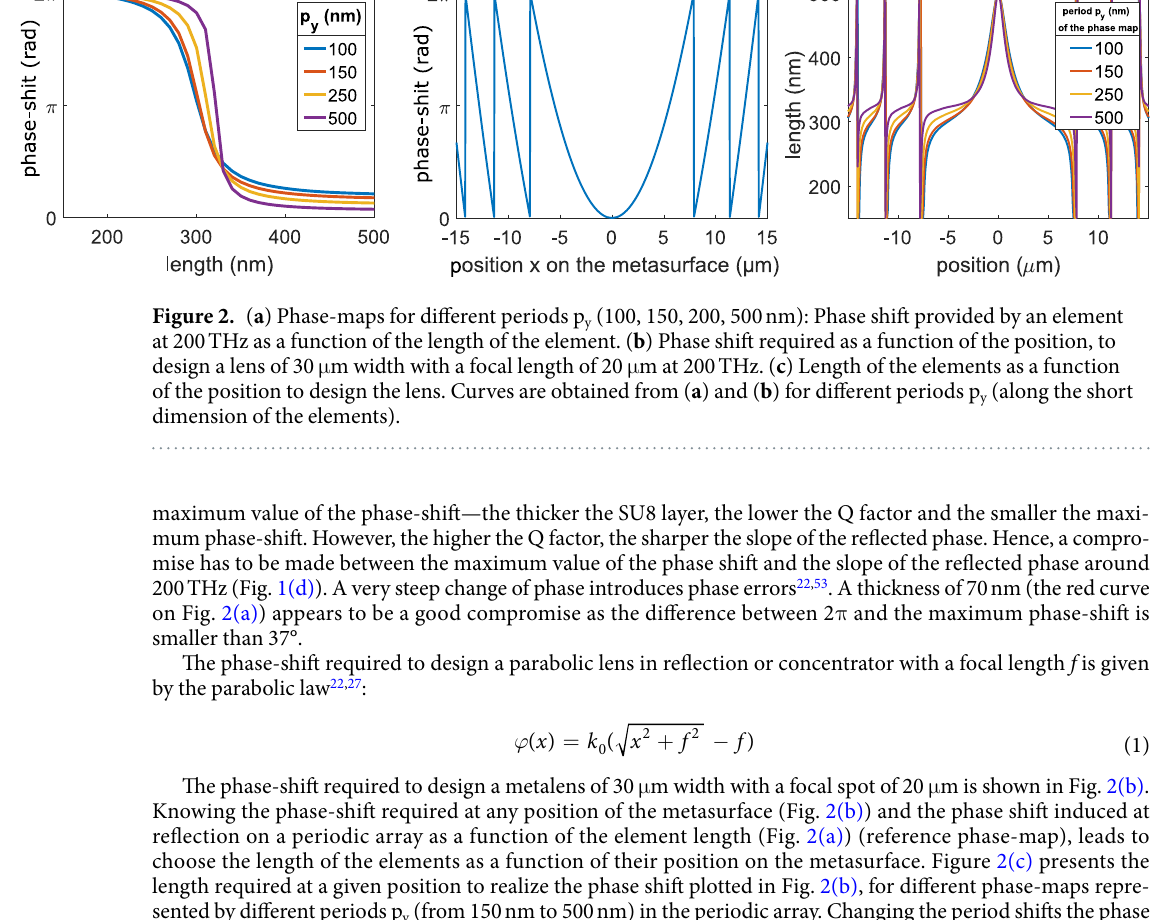
The phase-shift required to design a metalens of 30 μ m width with a focal spot of 20 μ m is shown in Fig. 2(b). Knowing the phase-shift required at any position of the metasurface (Fig. 2(b)) and the phase shift induced at reflection on a periodic array as a function of the element length (Fig. 2(a)) (reference phase-map), leads to choose the length of the elements as a function of their position on the metasurface. Figure 2(c) presents the length required at a given position to realize the phase shift plotted in Fig. 2(b), for different phase-maps repre- sented by different periods p y (from 150 nm to 500 nm) in the periodic array. Changing the period shifts the phase of the field reflected by an array of identical elements. This originates from two reasons: the near-field coupling that becomes stronger as the distance between the elements is decreased, and the density of elements itself in the limit of negligible near-field coupling. Indeed, the denser the array, the more field will be phase-shifted by the elements compared to the field which is only reflected by the ground plane. The total reflected field which is the sum of the field reflected by the mirror and the field scattered by the elements has therefore different phases for different densities. The two insets of Fig. 2(c) show the “z” component of the electric field in the near field of the elements of 300 nm length and 150 nm at their resonant frequency (respectively 200 and 300 THz). One-dimensional random metalenses. For a periodic metasurface, on one hand, choosing a period p y of a phase-map sets the density of elements per unit area of the periodic array: the relation between the period and the density is: ρ = p p 1/ . On the other hand, the main questions that arise are which density optimizes the focus- x y as will be seen later, the response is not straightforward. These questions are all the more important that random metasurfaces have fluctuations of the near-field coupling that may affect the efficiency if the density becomes too